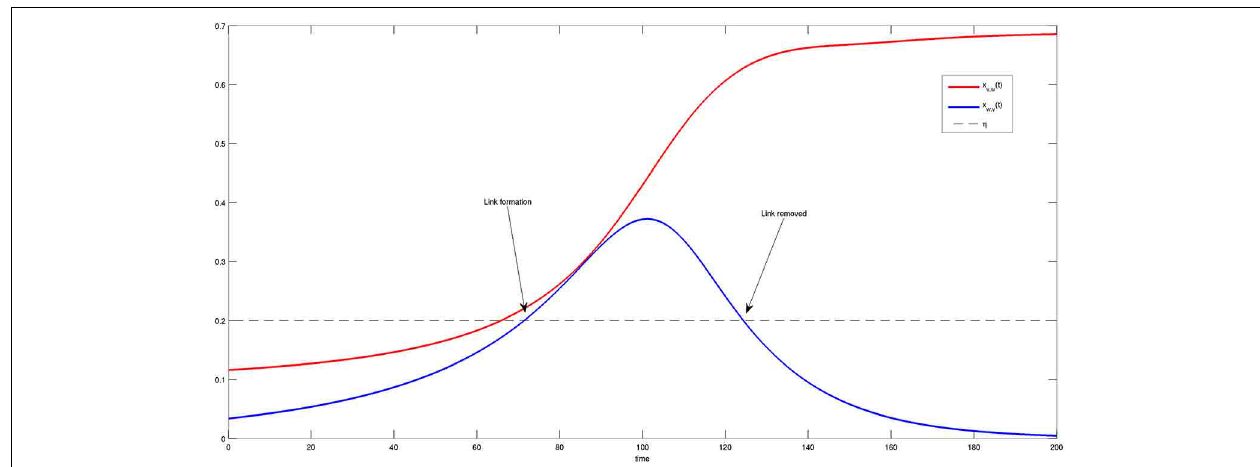
FIGURE 8 | Time course of two components x v , w ( t ) (red) and x w , v ( t ) (blue) of the system state X ( t ). When both components are greater than η (dashed black line), a link between v and w is